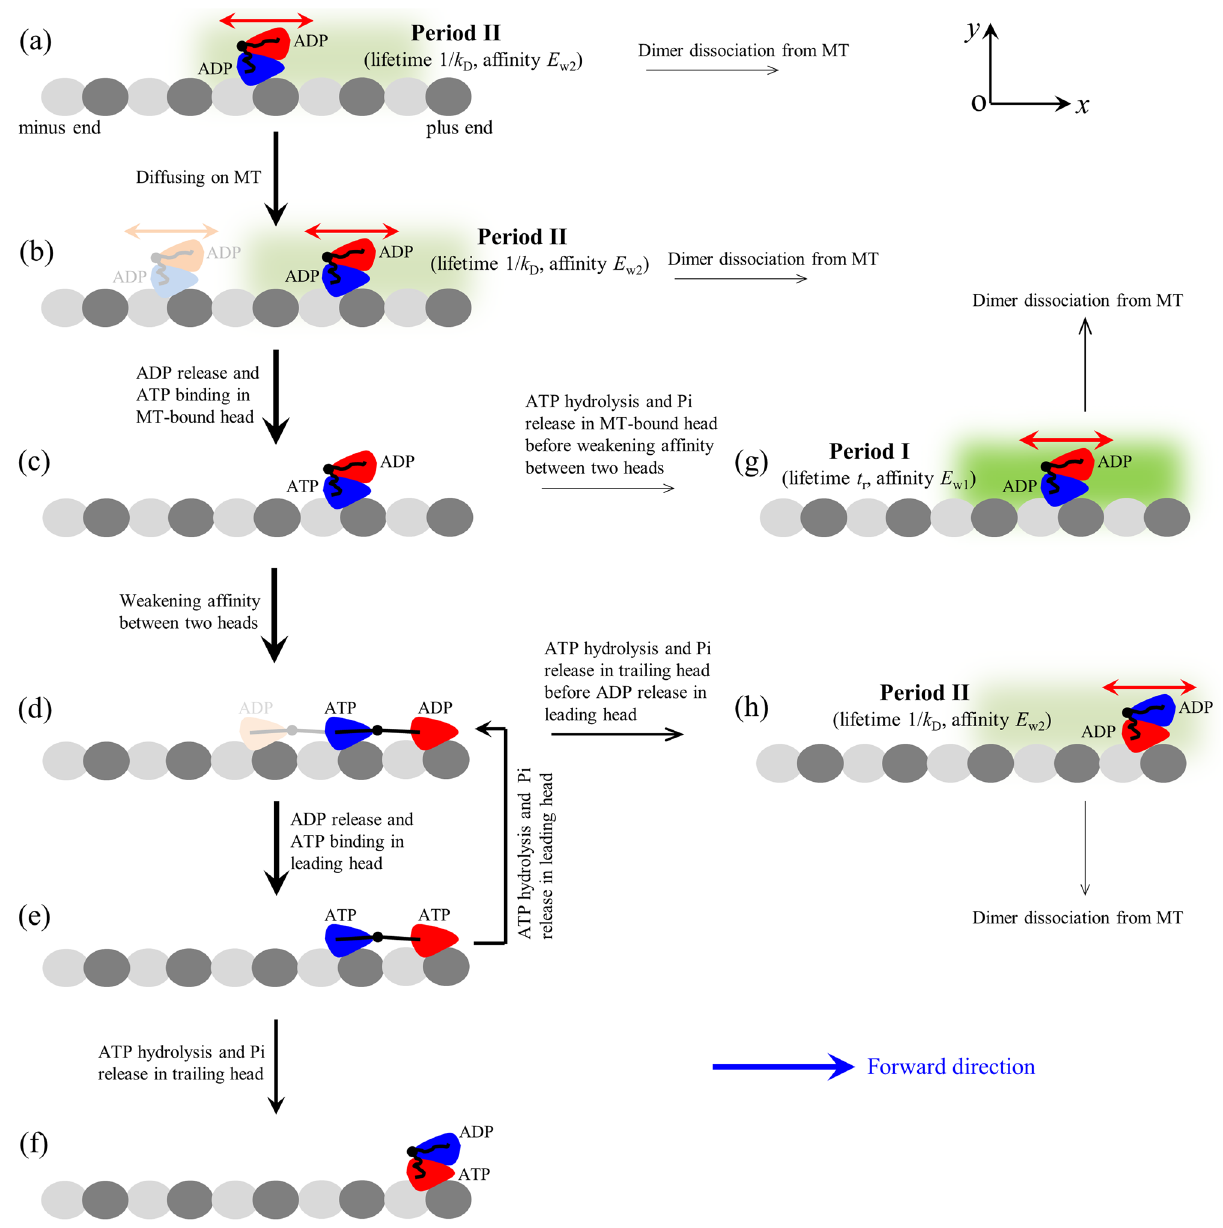
Figure 1. The model for processive walking and slipping of kinesin-8 motors. ( a )–( h ) Chemomechanical coupling pathway at saturating ATP (see text for detailed descriptions). Black arrows indicate state transitions, with the thickness of the arrow representing the magnitude of transition rate or probability under no load. Red arrows indicate slips. The blue arrow indicates the forward direction (the plus end of MT). Since in both ATP and ADP.Pi states the head has a high affinity to MT, for simplicity, we use ATP to represent both ATP and ADP. Pi states, or ATP hydrolysis and Pi release are treated as one